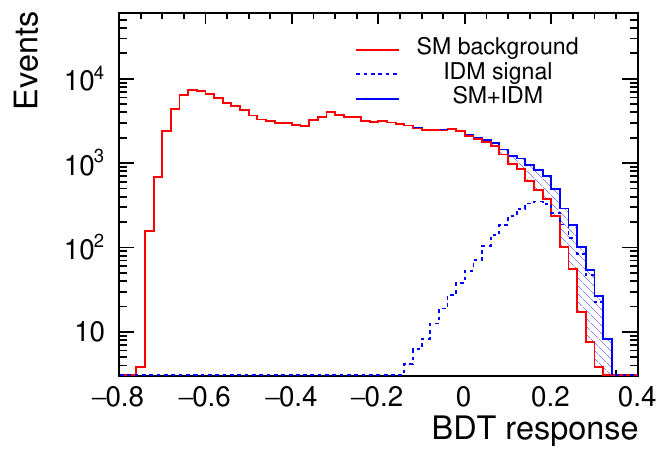
Figure 5 . Response distributions of the BDT classi(cid:12)ers used for the selection of AH production p events at CLIC, at s = 380 GeV. Signal samples for BP1 scenario and SM background are normalised to 1 ab (cid:0) 1